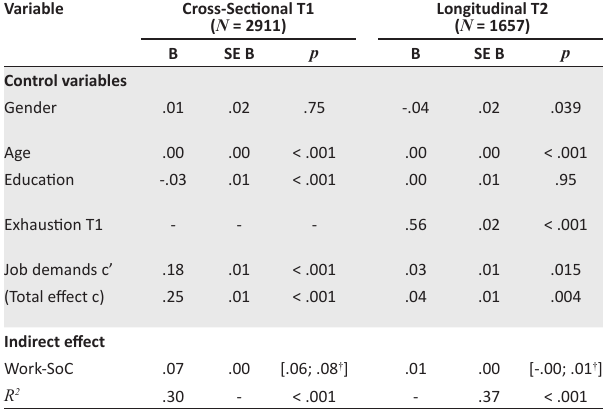
TABLE 4: Mediation analyses of job demands on exhaustion via work-related sense of coherence. Variable Cross-Sectional T1 ( N =